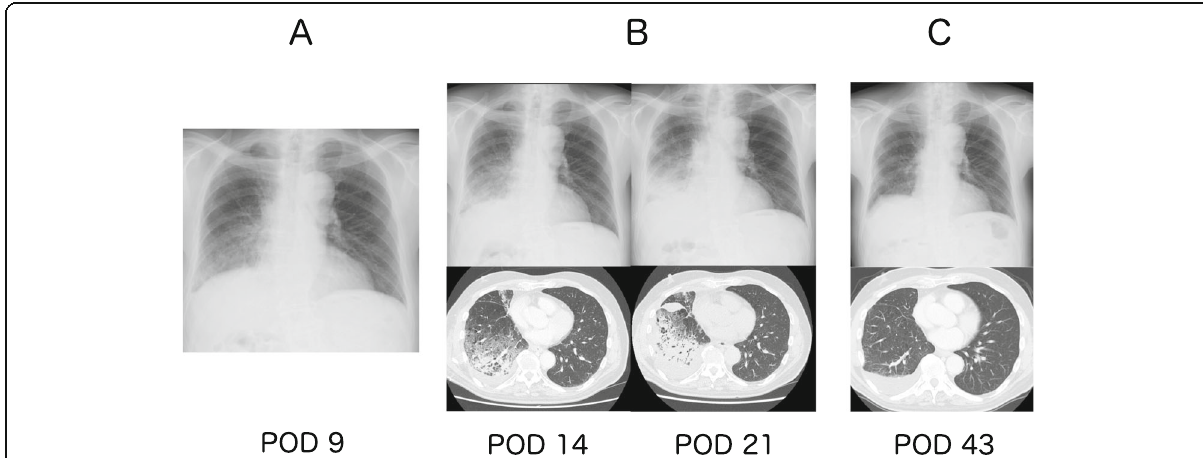
Fig. 1 Image findings. a On POD 9, unilateral consolidation appeared on the right lower field. Bacterial pneumonia was thought to have occurred as a common cause of postoperative complication and broad antibiotic therapy using meropenem was started. b After the initiation of meropenem, on POD 14, chest X-ray radiographs and computed tomography scans showed gradually worsening (ground glass, reticular shadows, consolidation, and pleural effusion only on the right operative side). On POD 21, the consolidation on the right side had exacerbated regardless of the administration of meropenem. Thus, we started to question if meropenem itself provoked and worsened the patient ’ s condition by causing drug-induced AEP. c On POD 43, after cessation of meropenem and use of oral prednisolone, the abnormal shadow in the chest